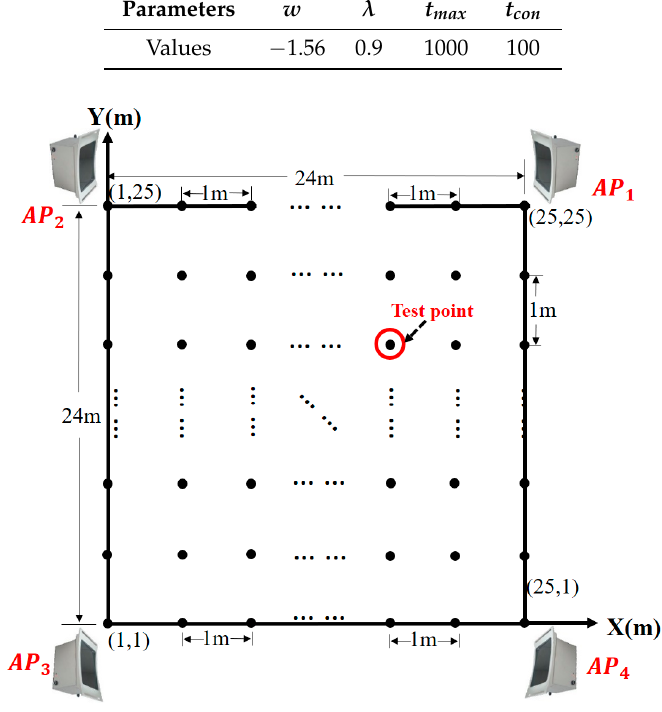
Figure 13. The plan of test site.